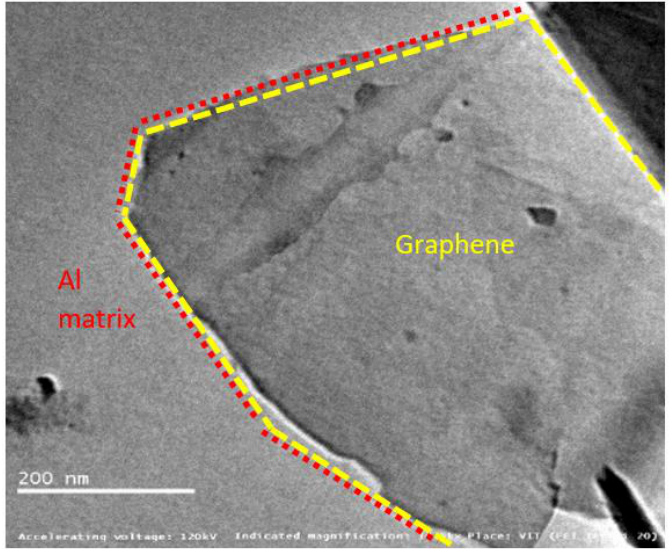
Figure 18. Graphene sheets embedded in AA7075 at 14.5 kX.